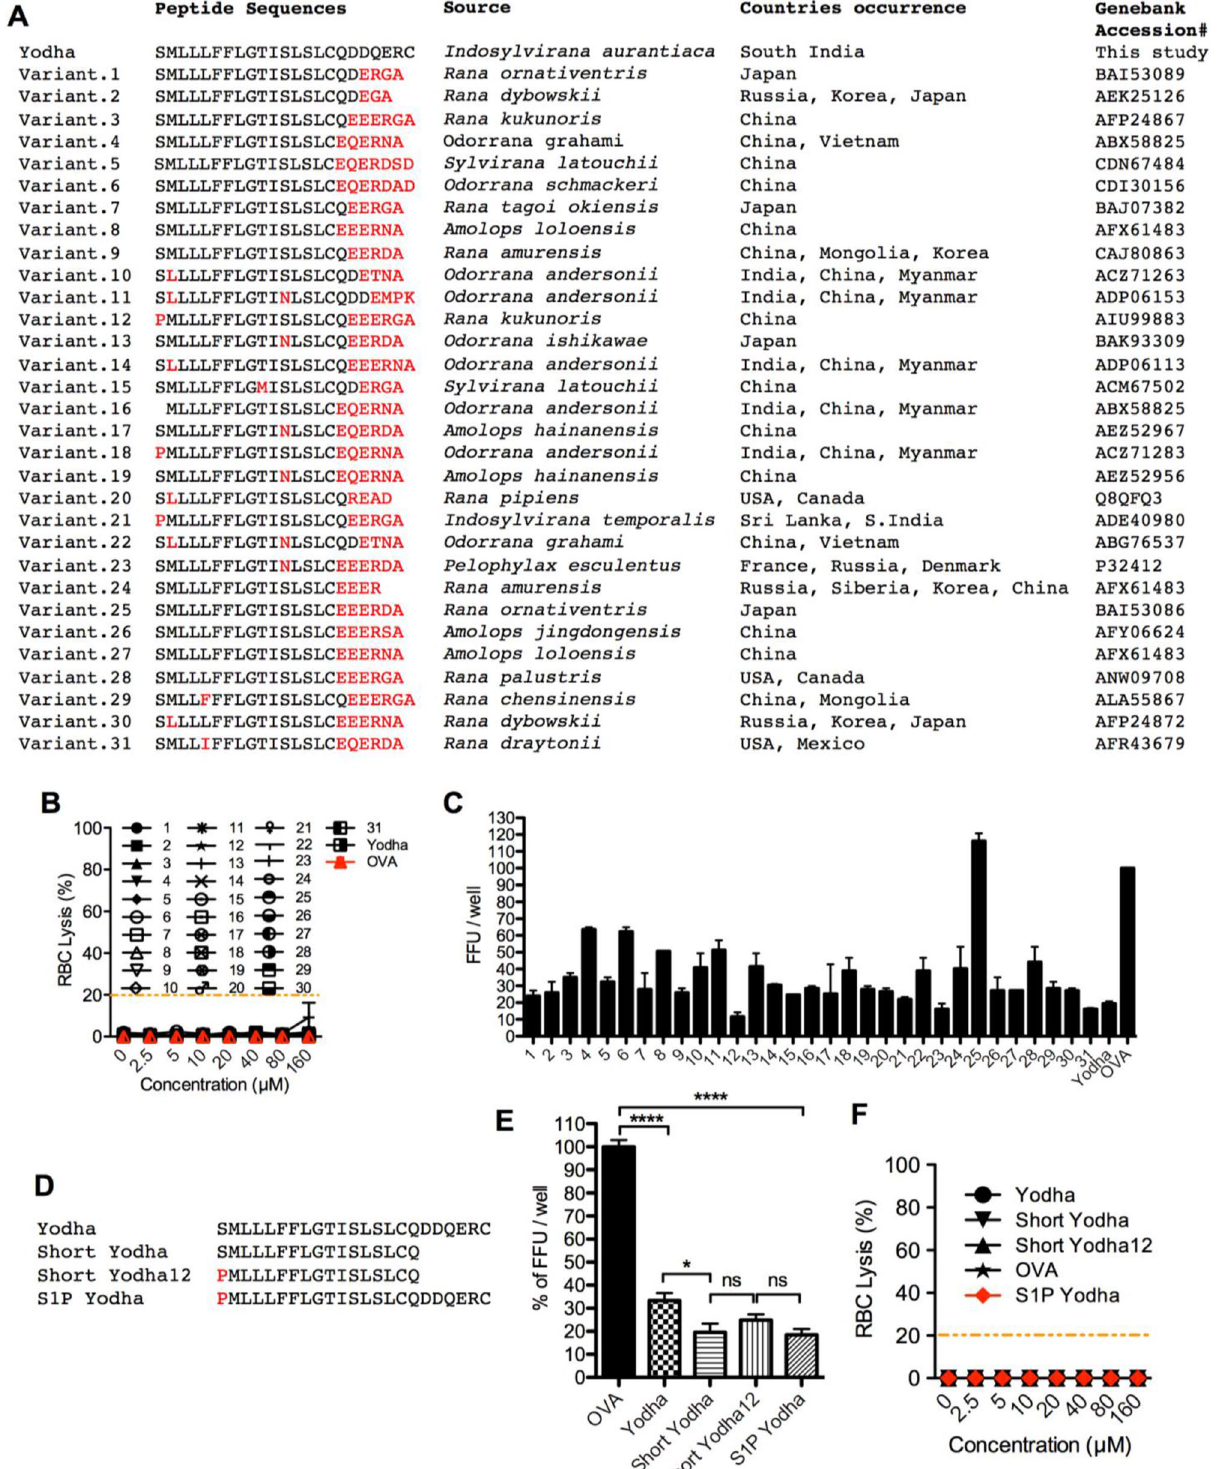
Figure 5. Naturally-occurring variants of Yodha peptides inhibit ZIKV. ( A ) A list of natural variants of the Yodha peptide, the identity and geographical distribution of amphibians that produce these peptides are shown. ( B ) Cytotoxicity tests show that the Yodha peptide variants are non-toxic to human RBCs. ( C ) Each of these naturally occurring variants of Yodha peptide was tested for their ability to neutralize ZIKV. All variants but one inhibited ZIKV. ( D ) Truncated and mutant Yodha peptides tested are shown. The ability of these to inhibit ZIKV is shown in ( E ) and the lack of toxicity of these are shown in ( F ). Statistical significance was assessed by T-test; two tailed. * p = 0.0215, ns; not significant, and ****p <